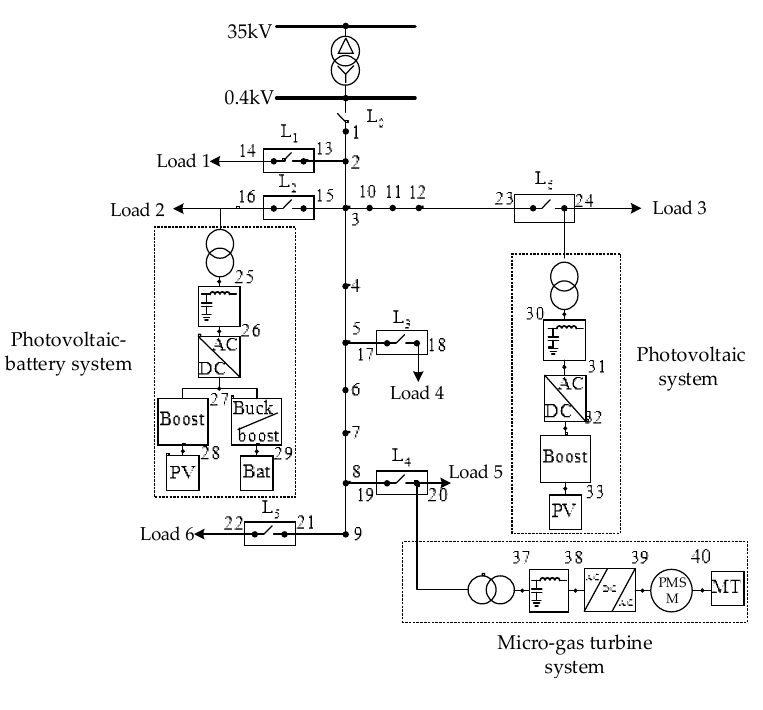
Figure 7. The low-voltage micro-grid example.